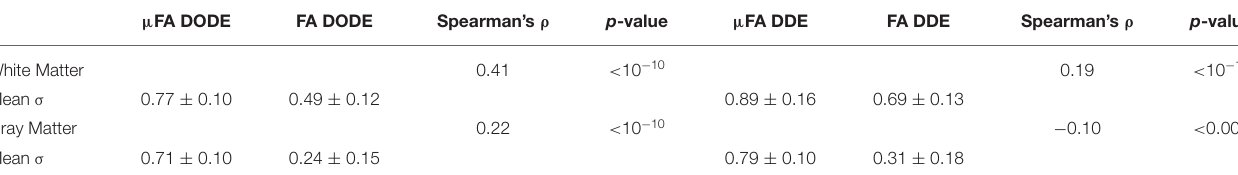
TABLE 1 | White matter and gray matter microscopic and fractional anisotropies, along with their spearman correlation coefficient and significance.